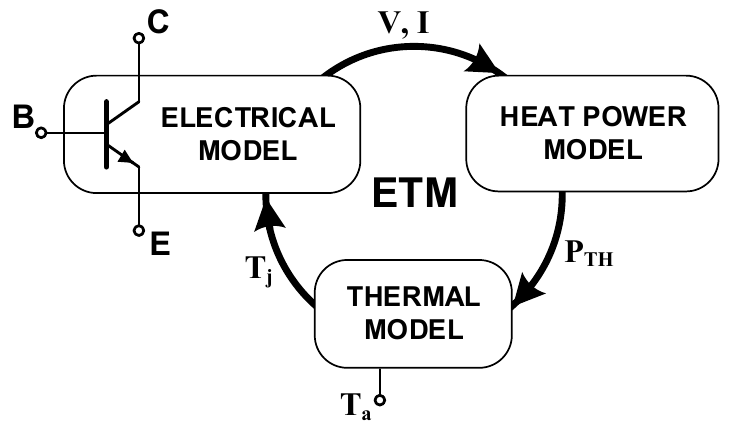
Figure 1. A block diagram of the electrothermal model of SiC bipolar junction transistor (BJT).